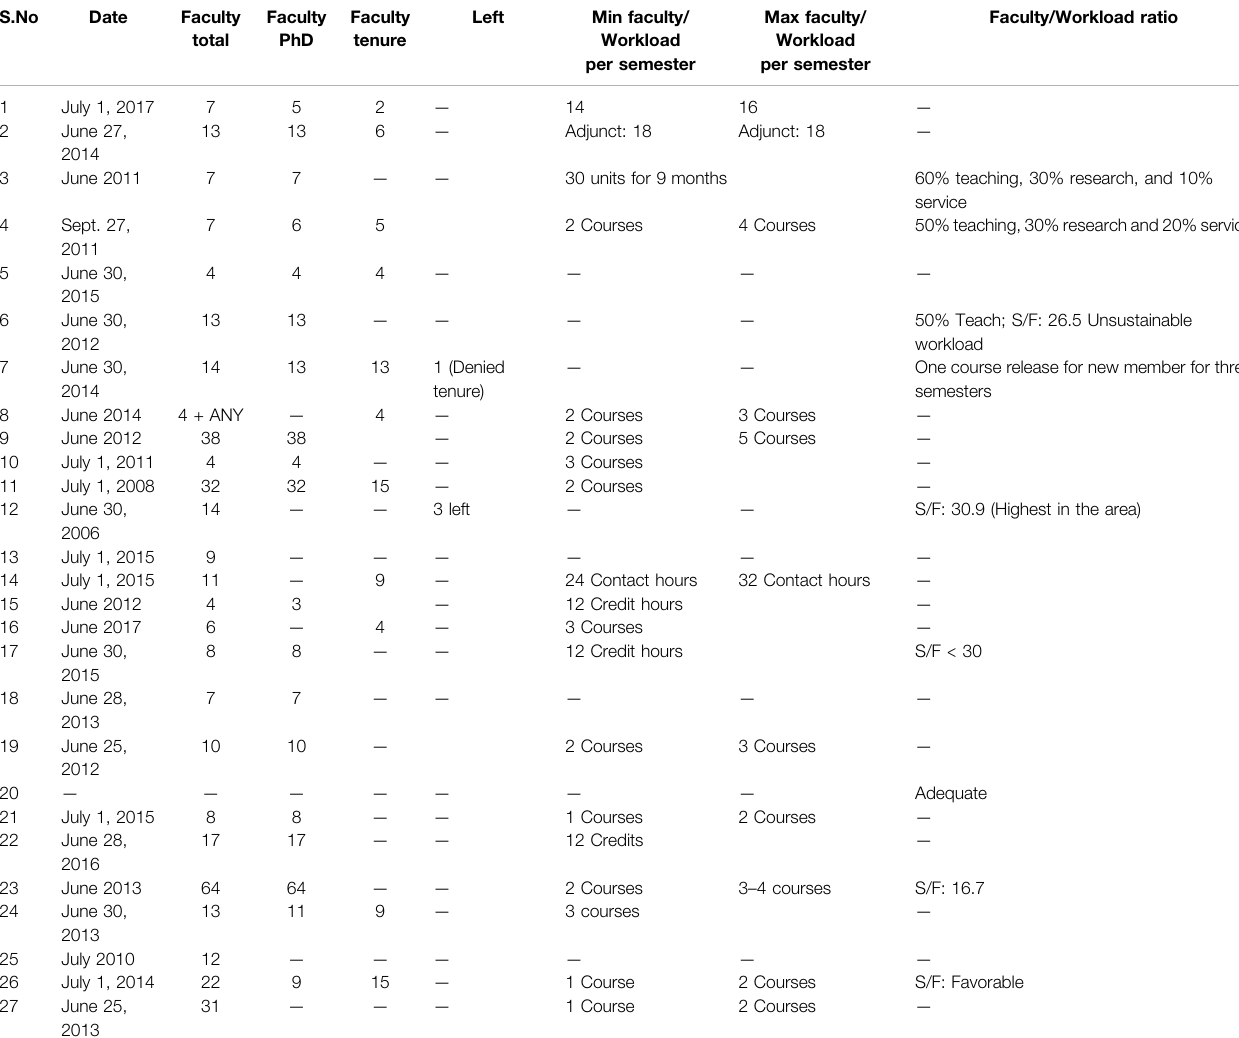
TABLE 2 | Document analysis (SSR) of 27 ABET accredited institutes for retention factors.